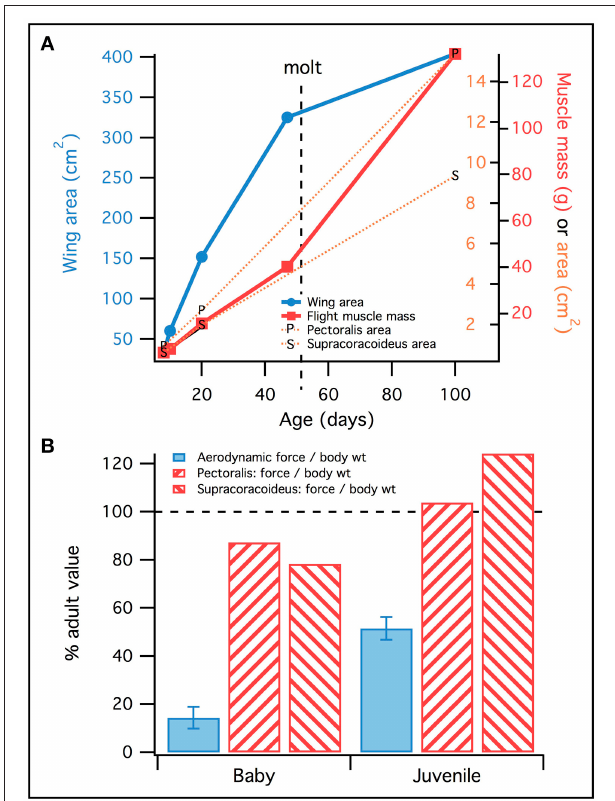
FIGURE 13 | Feathers vs. muscles . (A) Wing area (blue) increases faster than muscle mass (red; all flight muscles) or physiological cross-sectional area (orange), until molt. This suggests that early in ontogeny, muscles must be “pre-equipped” to flap bigger and better wings. (B) Consistent with (A), muscles reach adult levels of performance (maximum force/body weight; red) more rapidly than wings (force/body weight, from Heers et al., 2011; blue), suggesting that muscles are more functionally developed than feathers in baby and juvenile chukars. Data in (A) represents two wings, and muscles on both sides of the